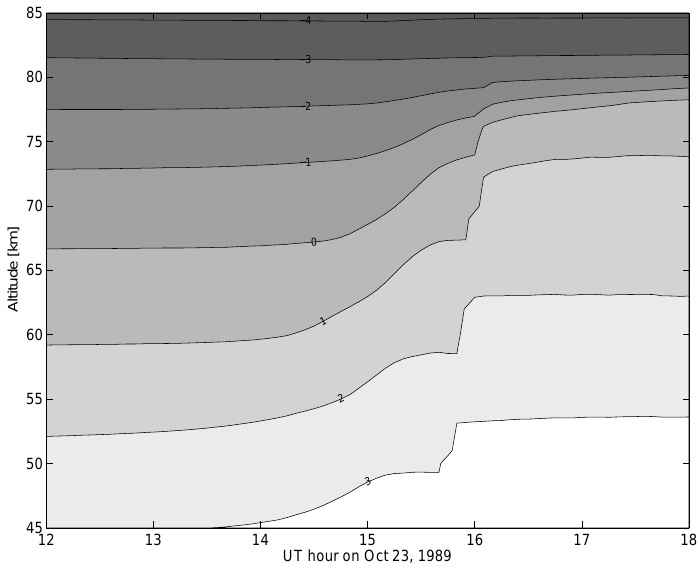
n − i − Fig. 6. Modelled negative ion to electron ratio, log 10 ( ), during the sunset of 23 October. The sharp changes seen around 16:00 UT indicate ), during the sunset of October 23. The sharp changes seen Fig. 6. Modelled negative ion to electron ratio, log 10 ( n i n − e n − e the times of the Earth’s shadow covering corresponding around 16:00 UT indicate the times of Earth’s shadow covering corresponding altitudes.